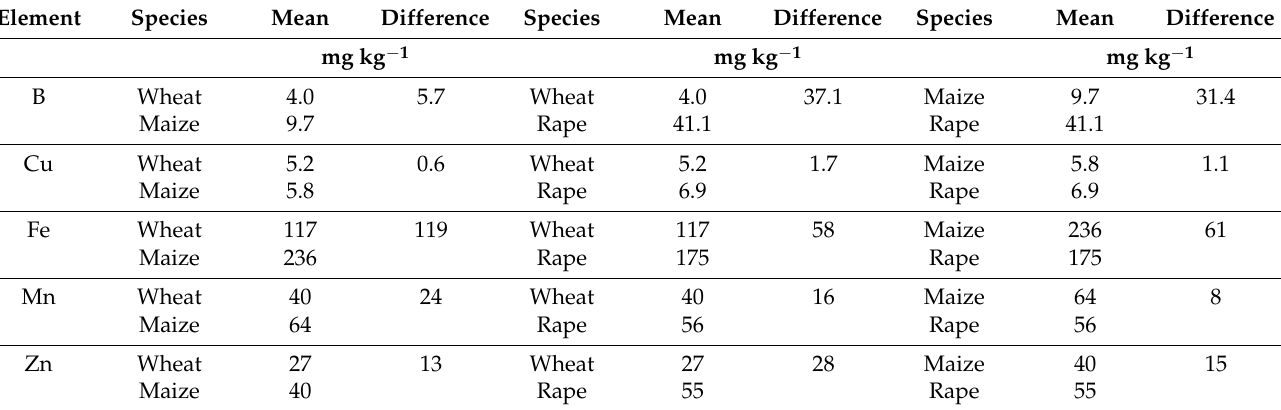
Table 6. Differences among species in the concentration of micronutrients in shoots—based on the mean of all cultivars